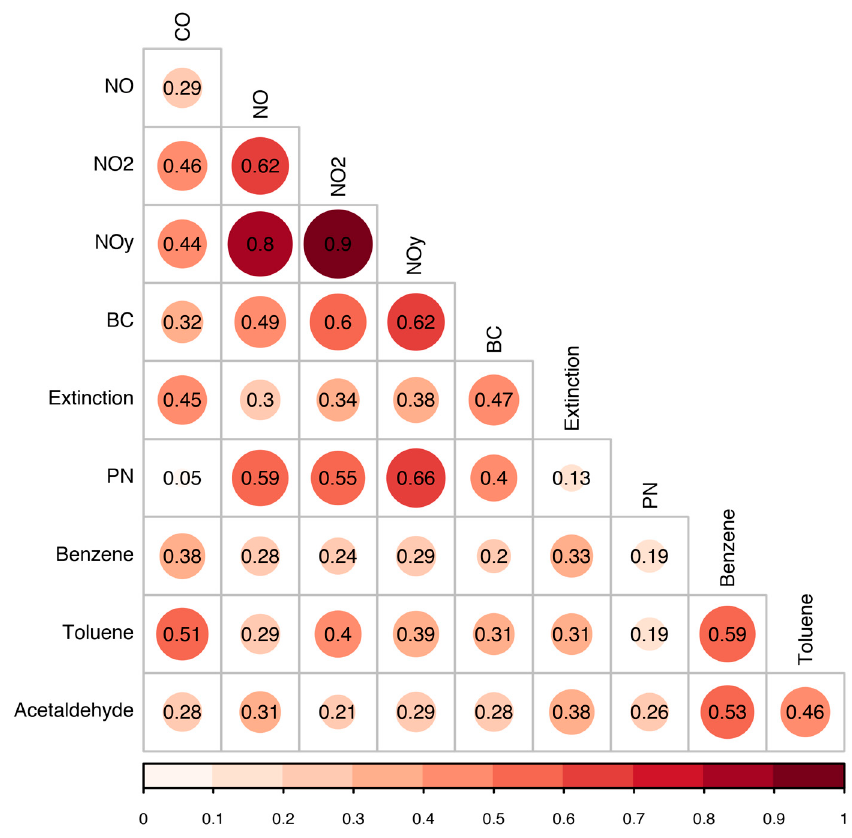
Figure 6. Pearson correlation between pollutant concentrations aggregated by 50 m road segment and hour.